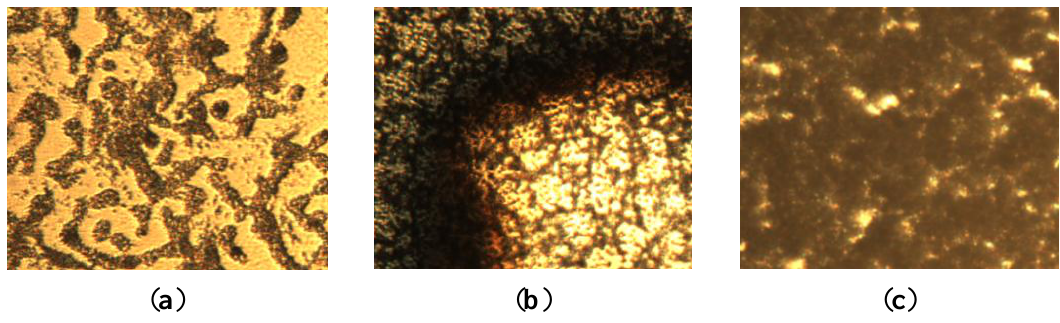
Figure 2. Optical microscope pictures (400×) of PVDF films after solvent-baking in the atmosphere. The weight percentages of PVDF are ( a ) 5 wt%; ( b ) 10 wt%; ( c ) 15 wt%.